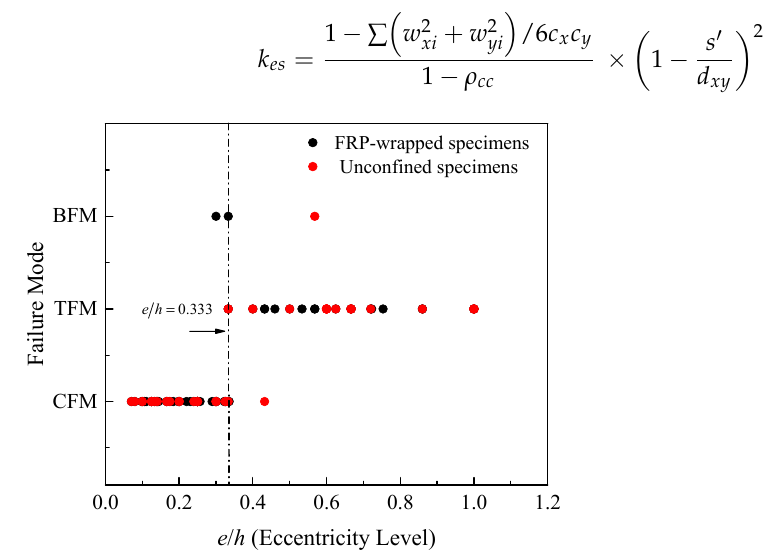
Figure 6. Eccentric load ratio via failure mode.